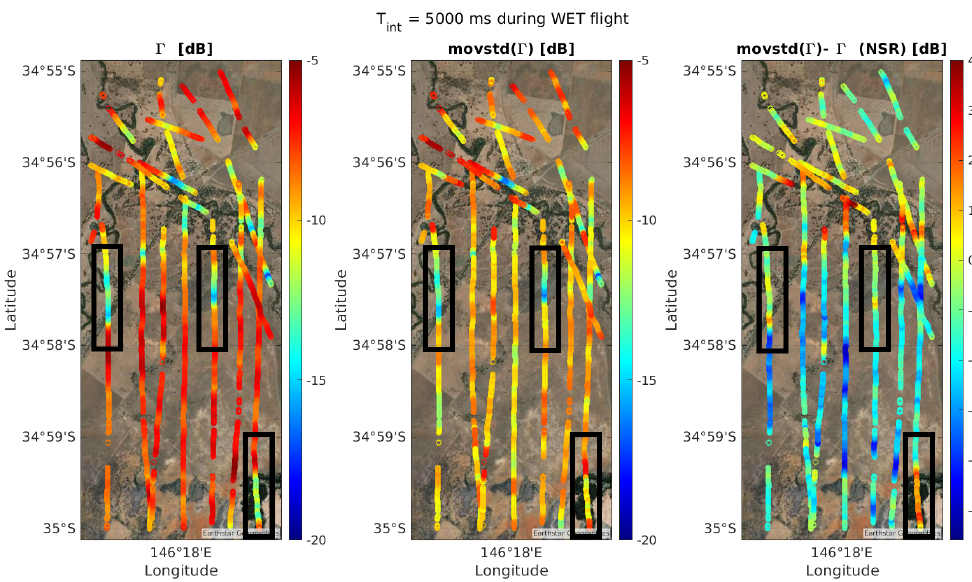
Figure 12. Same as Figure 11 but for the Wet